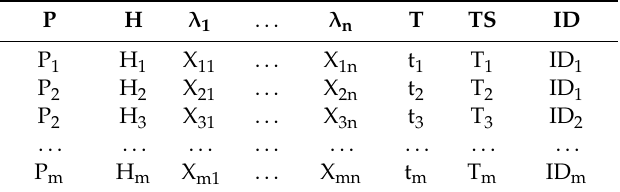
Table 1. Spectral file format of the portable smart